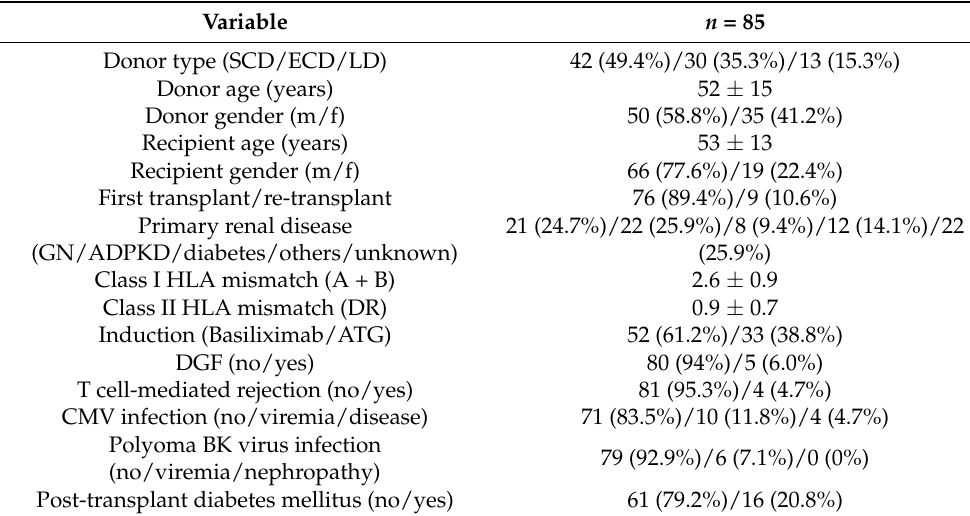
SCD, standard criteria deceased donor; ECD, expanded criteria deceased donor; LD, living donor; GN, glomeru- lonephritis; ADPKD, autosomal dominant polycystic kidney disease; DGF, delayed graft function; CMV,